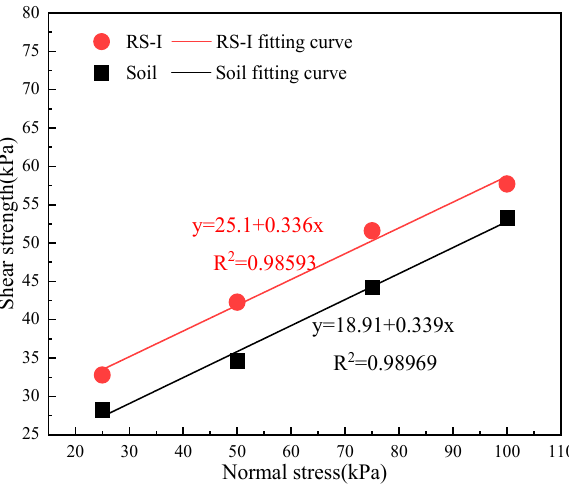
Figure 14. Relationship between shear strength and normal stress of specimen in shear resistance test. Table 6. Soil shear strength and root–soil interface bond strength parameters.